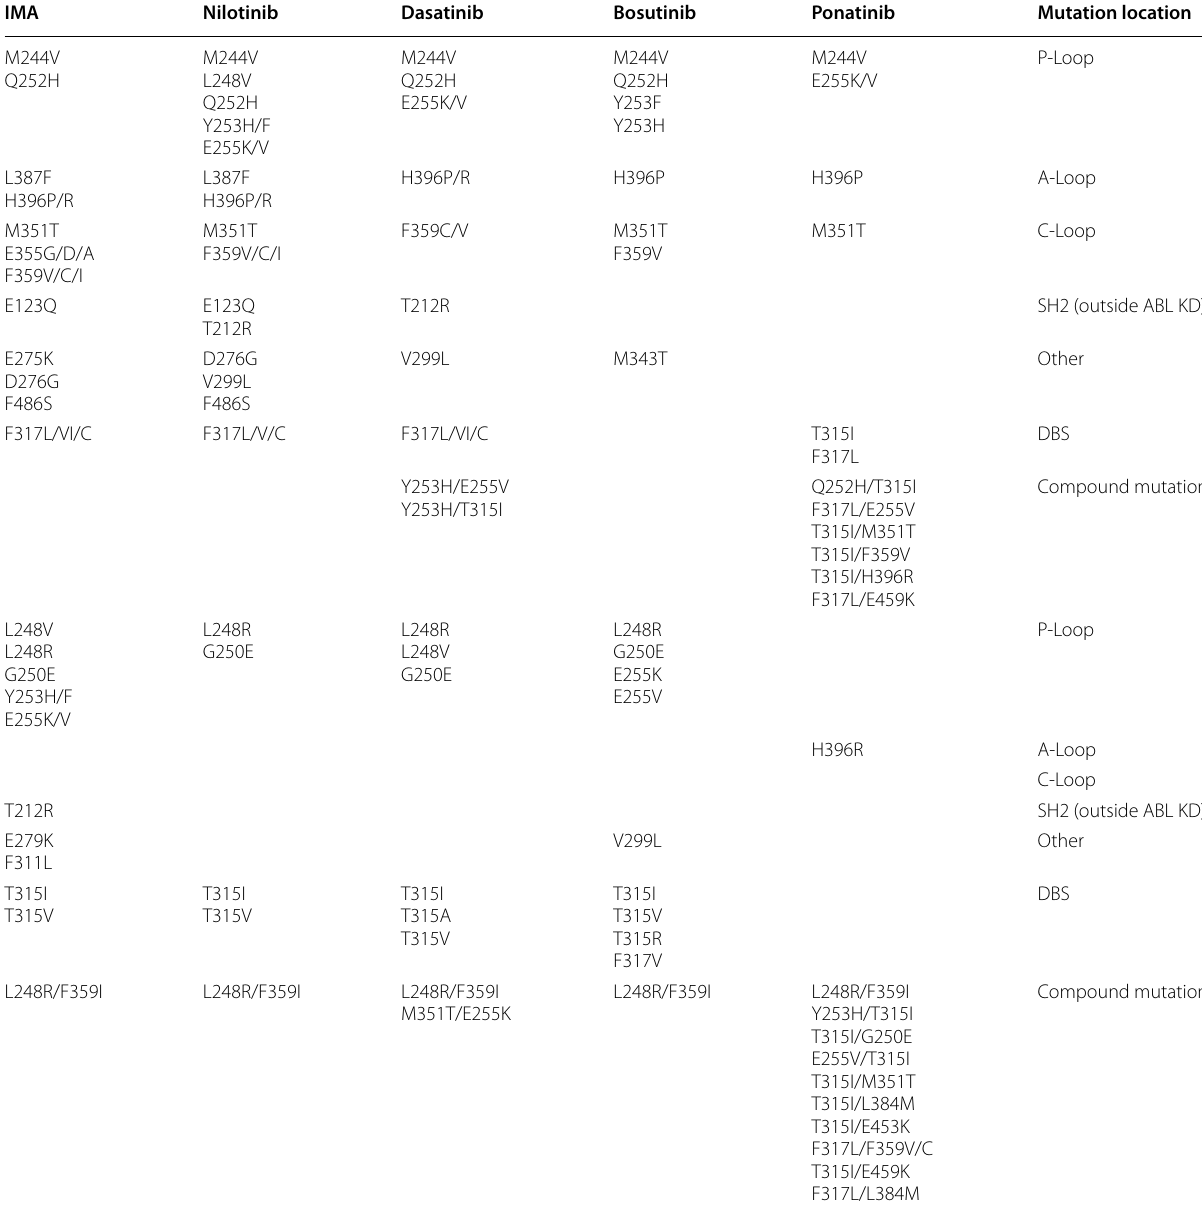
Table 1 Mutations inside the BCR-ABL kinase domain and resistance to medicines received in patients